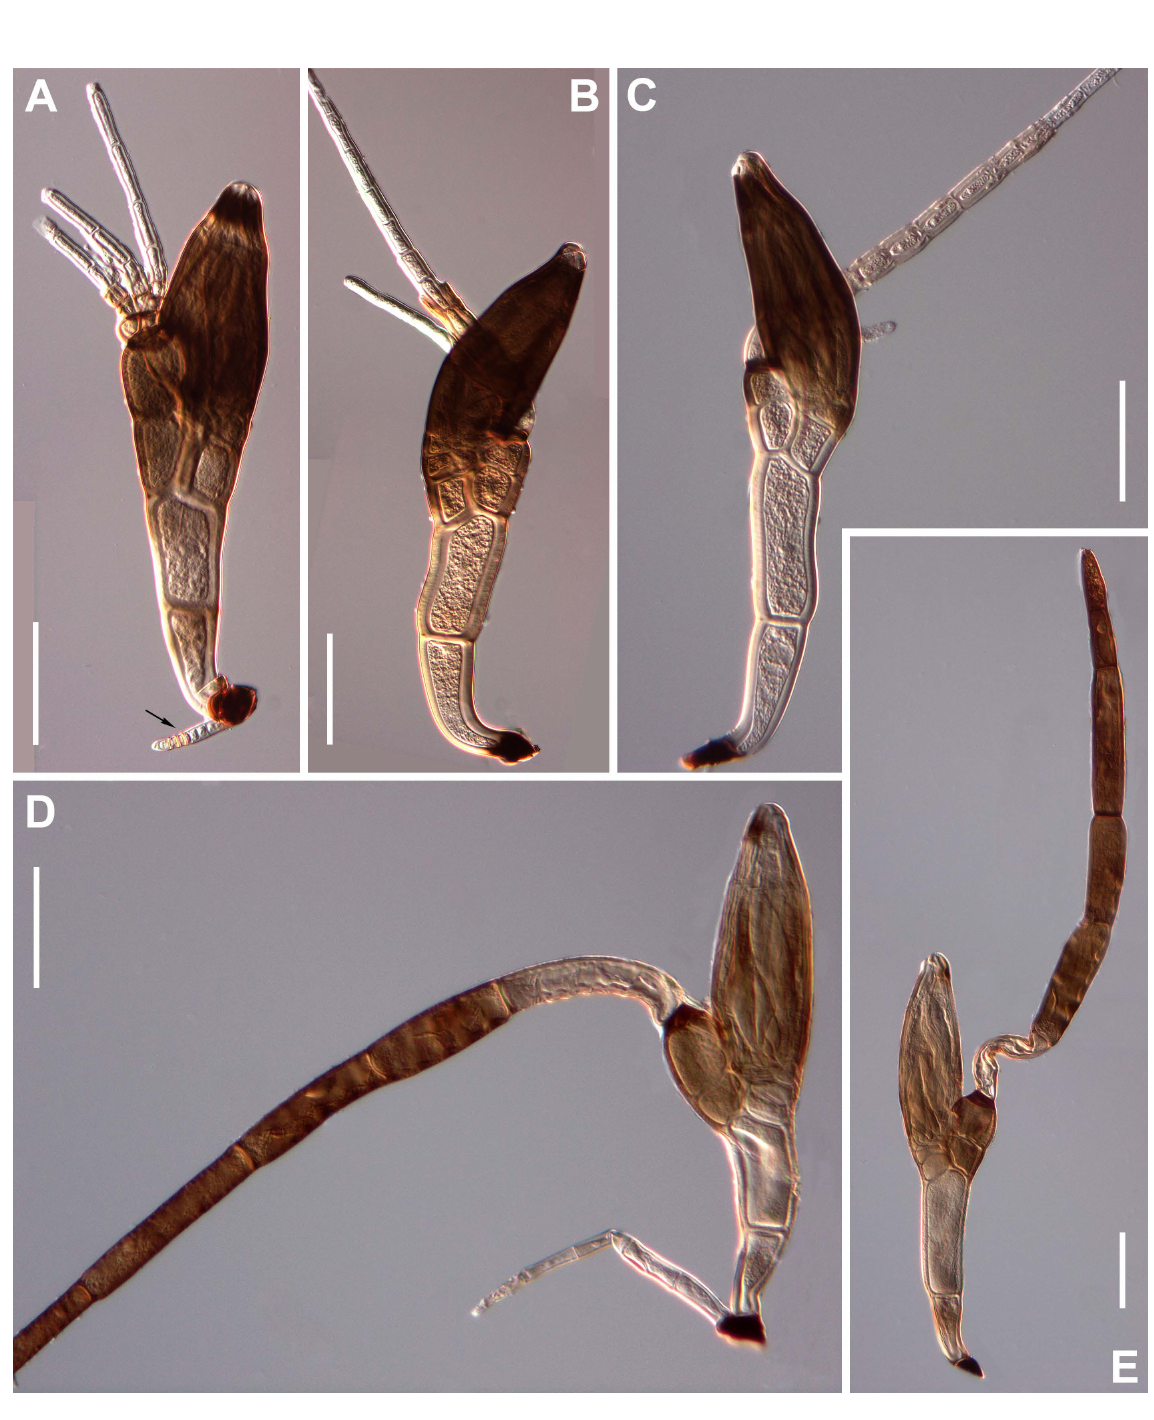
Fig. 35. Laboulbenia spp. A . L. inflata Thaxt. Female thallus paired with a diminutive male (arrow).